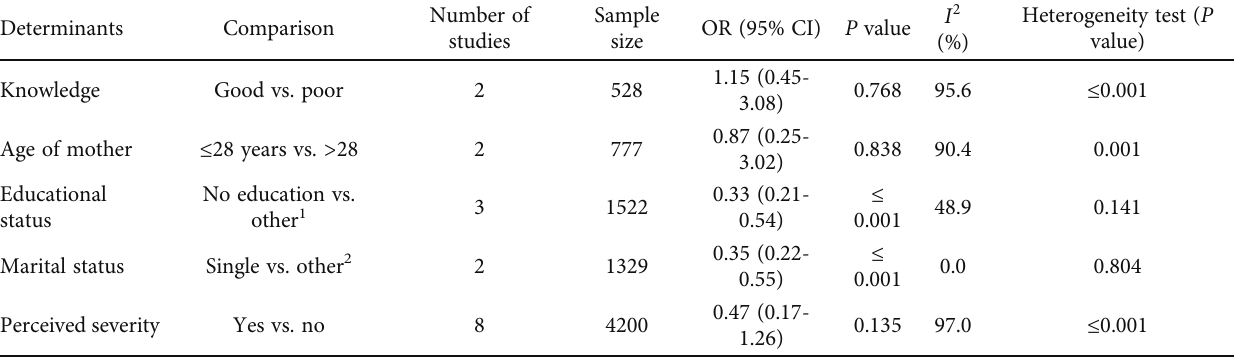
Table 3: Predictors of mothers ’ care-seeking behavior for common childhood illnesses in